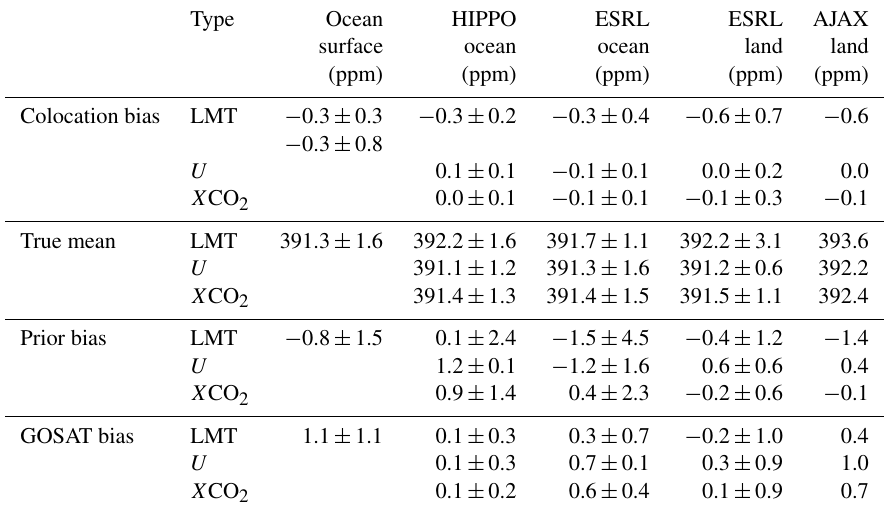
Table 4. Biases versus validation data. See Table 3 for terminology used in this table. Note that all data are averaged by location or campaign. The ± represents the variability of the bias by location or campaign, a key metric in the data quality.